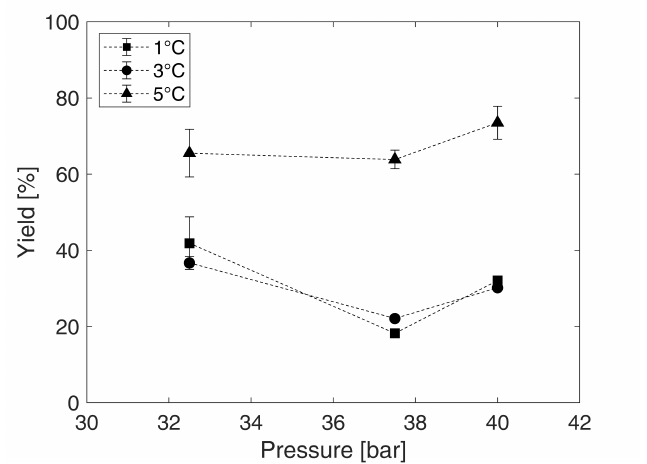
Figure 5. Reached yield in % expressed as a quotient of the reached concentrate mass m c after the concentration using CO 2 hydrate technology and the mass m 0 of the initial water-sucrose model solution (10 °Brix) at pressures of 32.5 bar, 37.5 bar, and 40 bar combined with temperatures of 1 °C, 3 °C, and 5 °C (error bars: standard error of the mean according to Section 2.9, the standard errors of the mean are given in Table